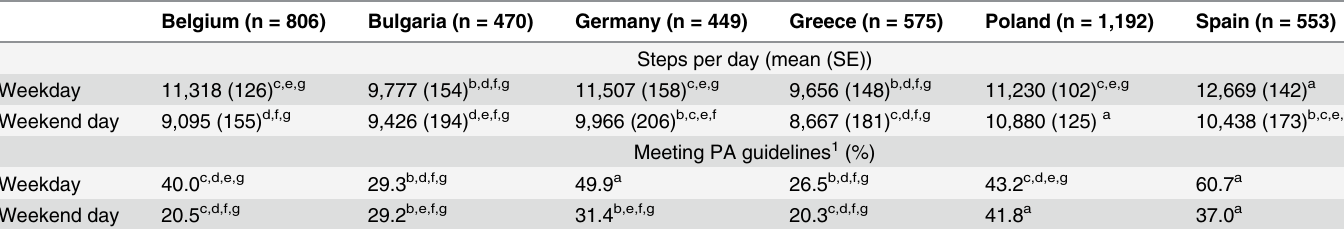
Table 4. Levels of physical activity in preschool children from six European countries (n = 4,045) (adjusted for sex and